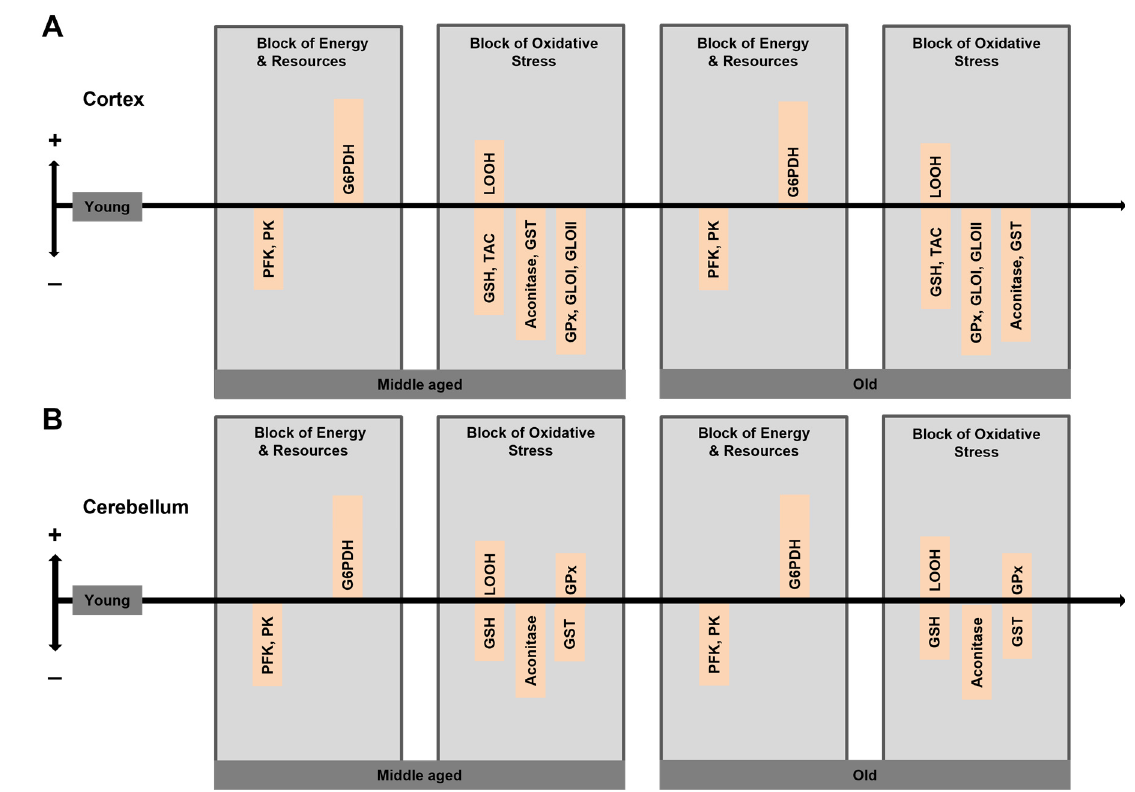
Figure 3. Aging-related changes in the energy homeostasis and the redox state of the brain. Summary of data from the mouse cerebral cortex ( A ) and cerebellum ( B ). Deduced from [24,25].